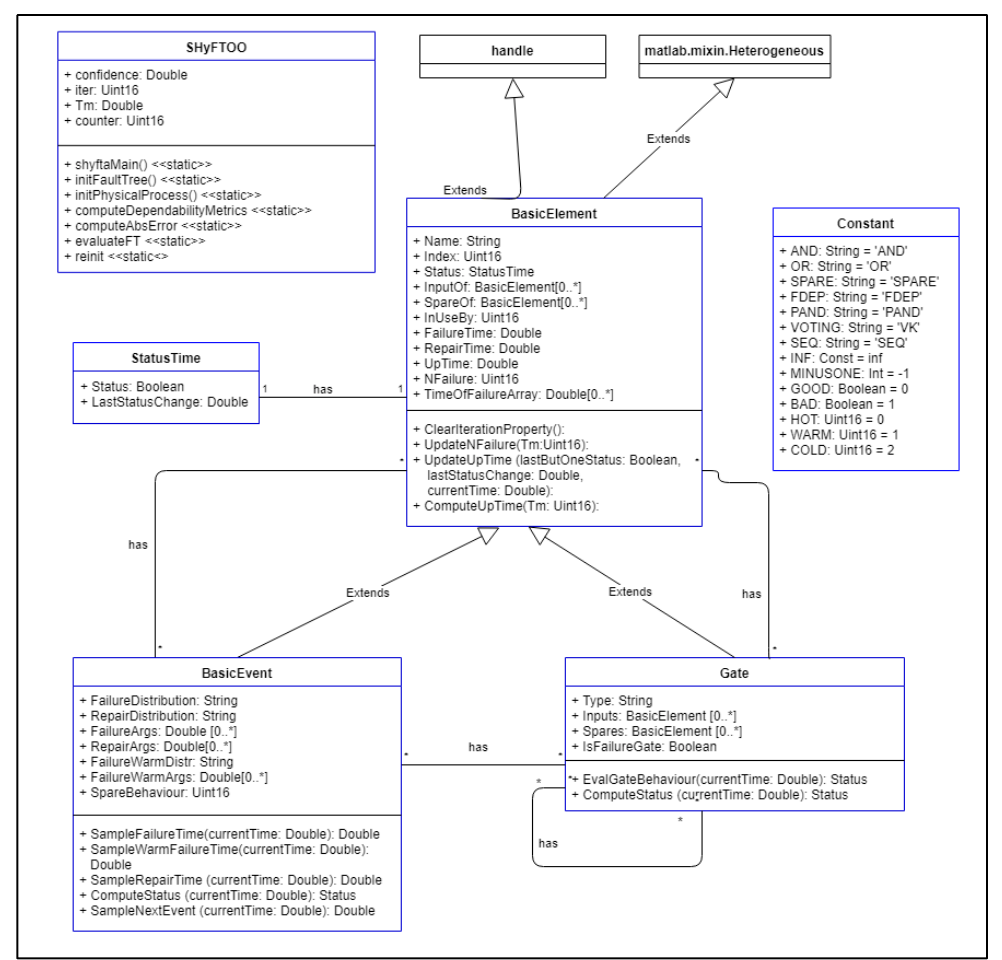
Figure 1. SHyFTOO library: UML Class diagram (developed in Matlab ® ).